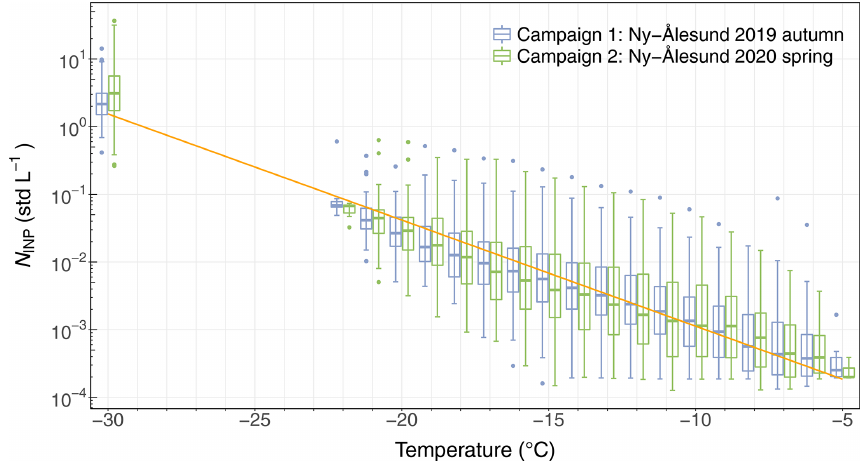
Figure 3. Box plot of observed INP concentrations as a function of nucleation temperature during the measurement campaigns in au- tumn 2019 (violet) and spring 2020 (green) in Ny-Ålesund, Svalbard. The orange line indicates a log-linear fit to all data